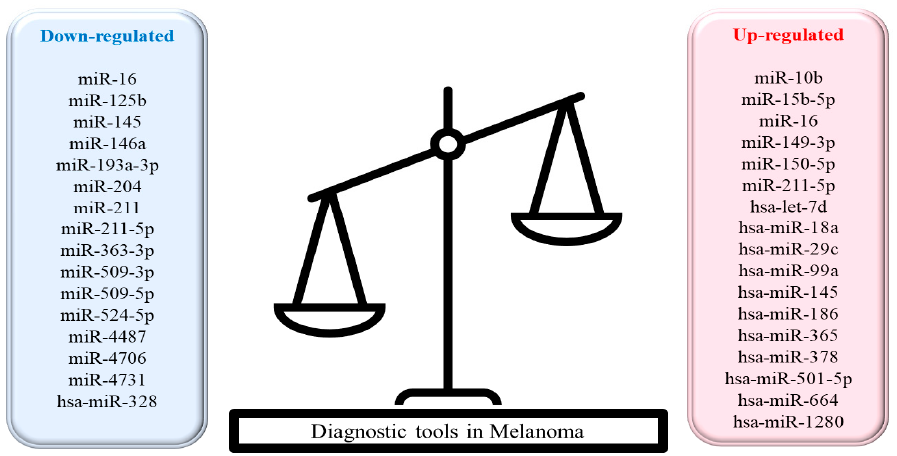
Figure 3. MicroRNAs as diagnostic tools in CMM melanoma. The figure shows the application of downregulated and upregulated miRNAs that can be used as diagnostic tools in cutaneous ma- lignant